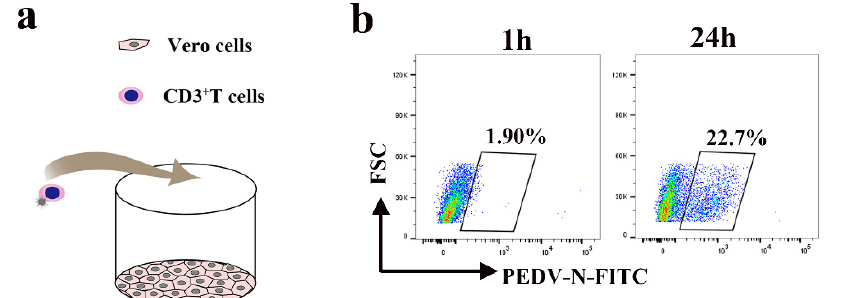
Figure 9. PEDV-loaded CD3 + T cells mediate transfer infection. ( a ) The model of the co-culture assay with blood-derived CD3 + T cells infected with PEDV and Vero. ( b ) Blood-derived CD3 + T cells infected with PEDV and co-cultivated with Vero cells at the indicated time points. The CD3 + T cells were washed, then PEDV + Vero cells were detected using FACS.